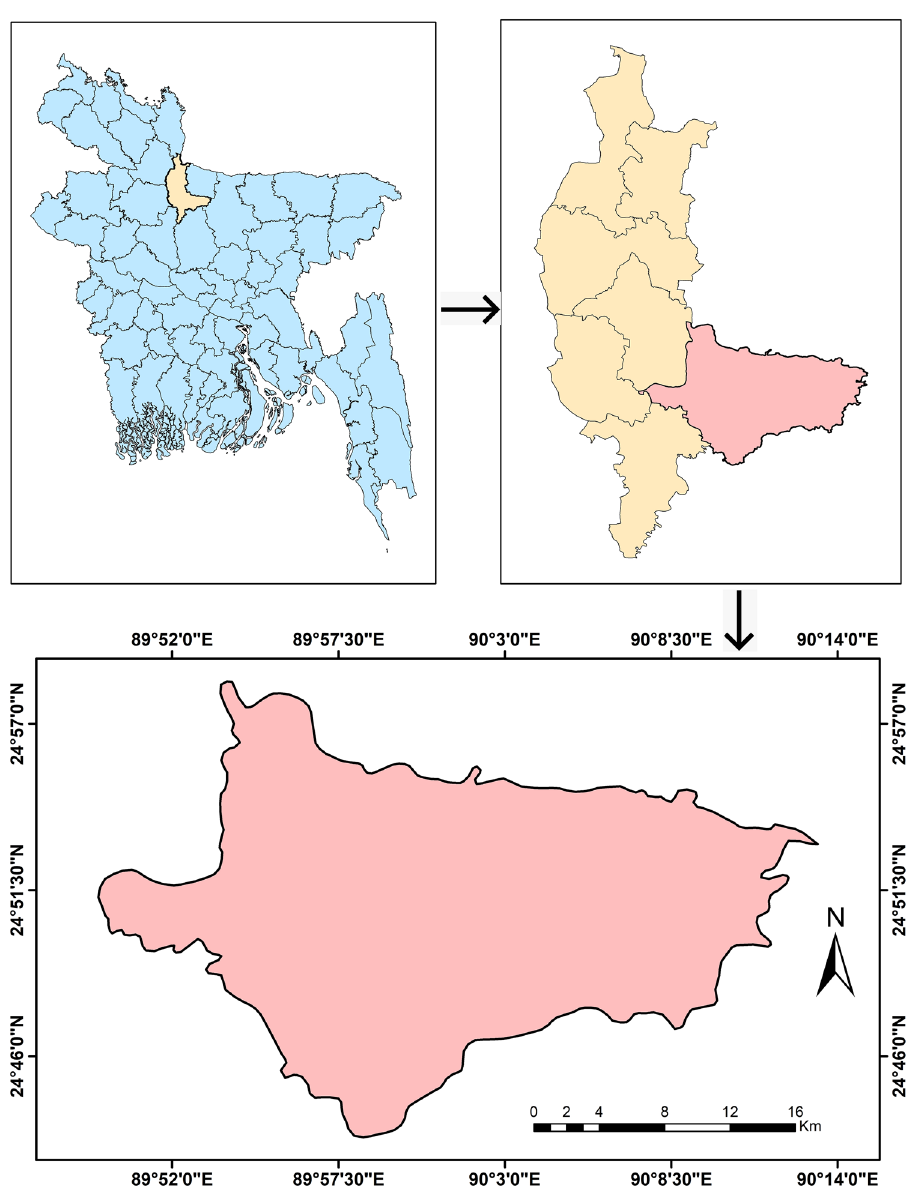
Fig. 1 Study area map (Jamal- pur Sadar